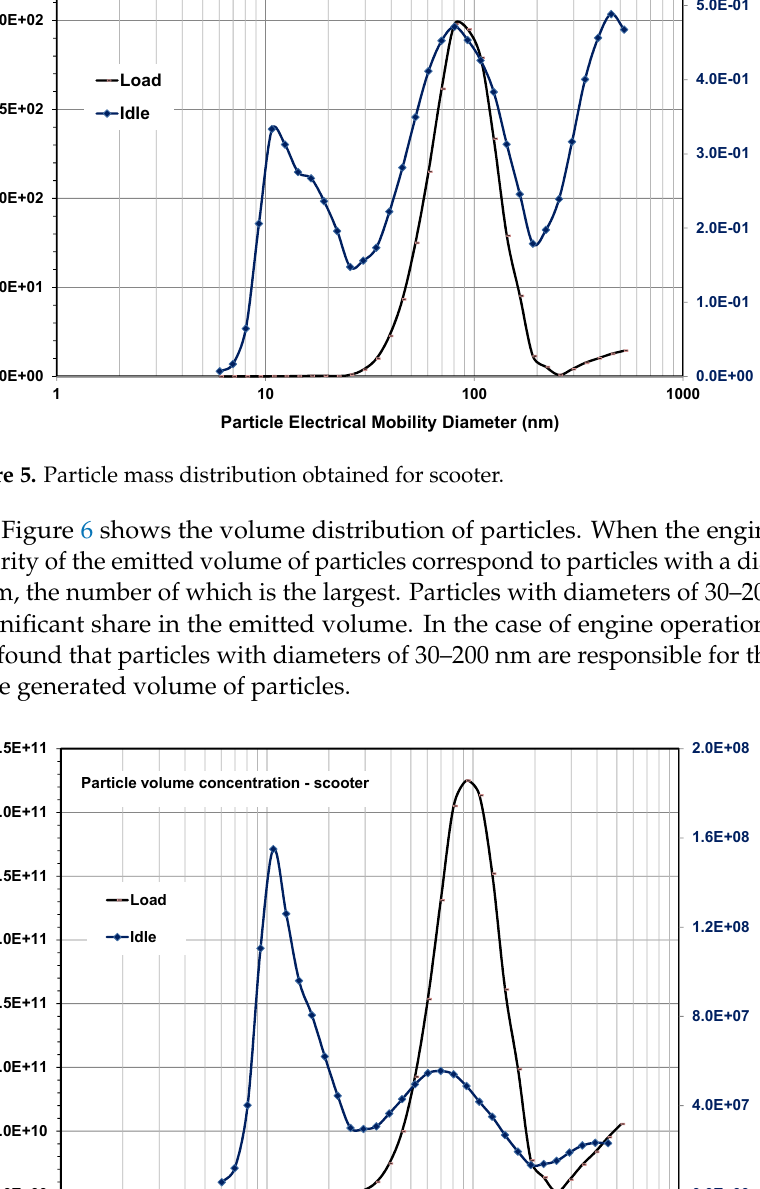
Figure 4. Particle number distribution obtained for scooter.